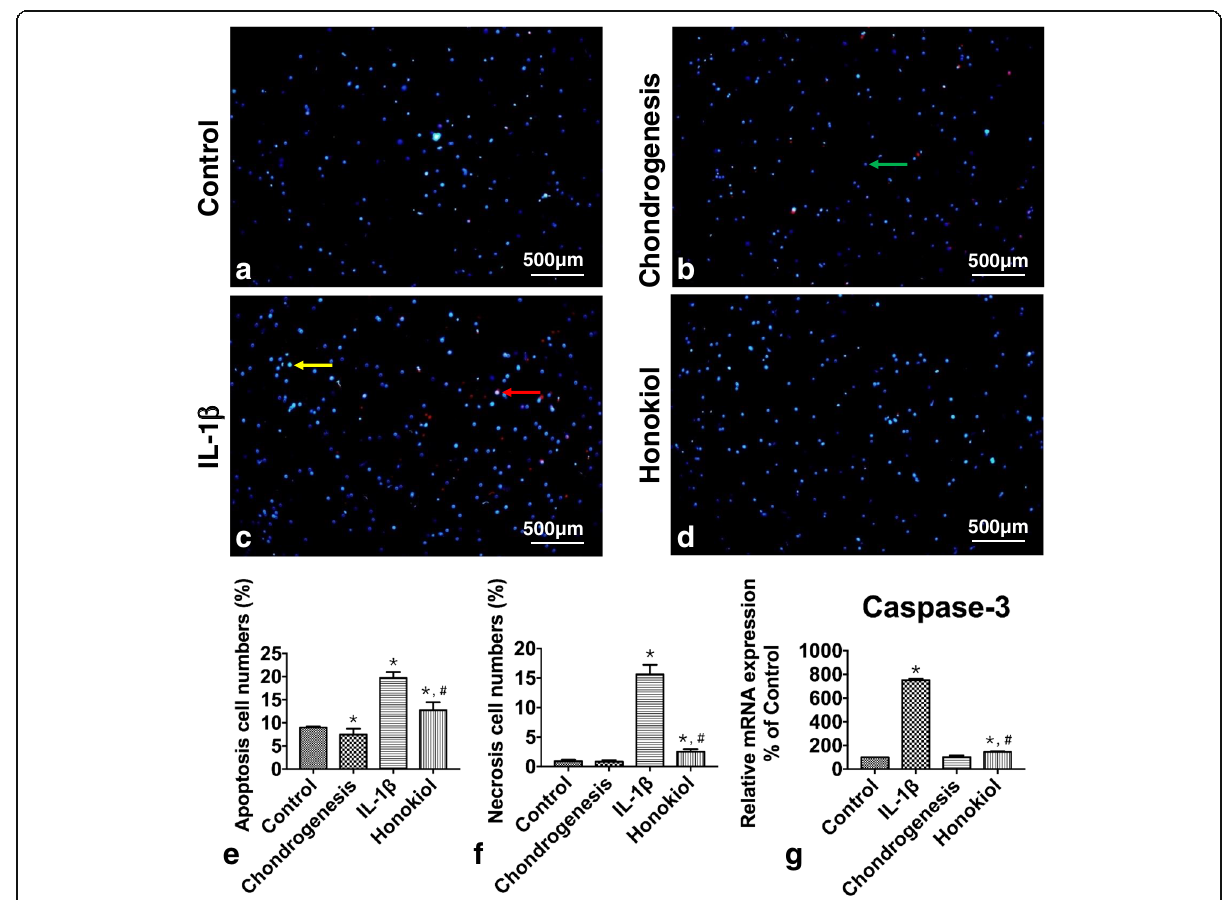
Fig. 4 The effects of honokiol on apoptosis and necrosis of hUC-MSCs. 2nd passage hUC-MSCs were cultured in 4 groups, a : Control, b : Chondrogenesis, c : IL-1 β , d : Honokiol for 2 weeks. At the end of 2nd week, cells were stained with Hoechst 33,342 and PI for apoptosis and necrosis analysis. Green arrow indicated the normal cell, yellow arrow indicated the apoptotic cell and red arrow indicated the necrotic cell. The apoptotic cell number and necrotic cell number were analyzed by ImageJ, all data were presented